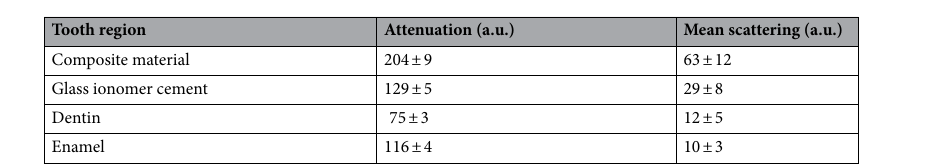
Table 1. Attenuation and mean scattering strength for different tooth regions. The values are calculated from a Gaussian fit to the histogram of a region of interest in the respective tooth region.